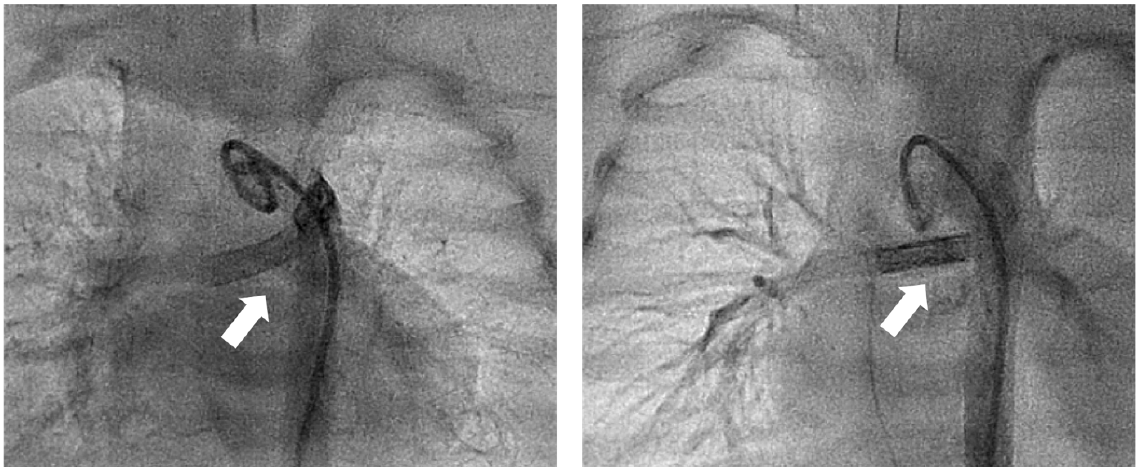
Figure 2. Downsizing of PDA stent. Frontal view, angiography of aortic arch showing stented PDA (white arrow) after birth at day 4 ( left ) and after re-intervention at day 17 ( right ). At day 4 ( left ), two coronary stents (Multi-Link Vision ® , 3.5 mm diameter) were implanted. At day 17, according to a mismatch of pulmonary hyperperfusion, with clinical signs of necrotising enterocolitis, five further coronary stents were implanted, reducing the PDA stent diameter from 3.3 to 2.8 mm.